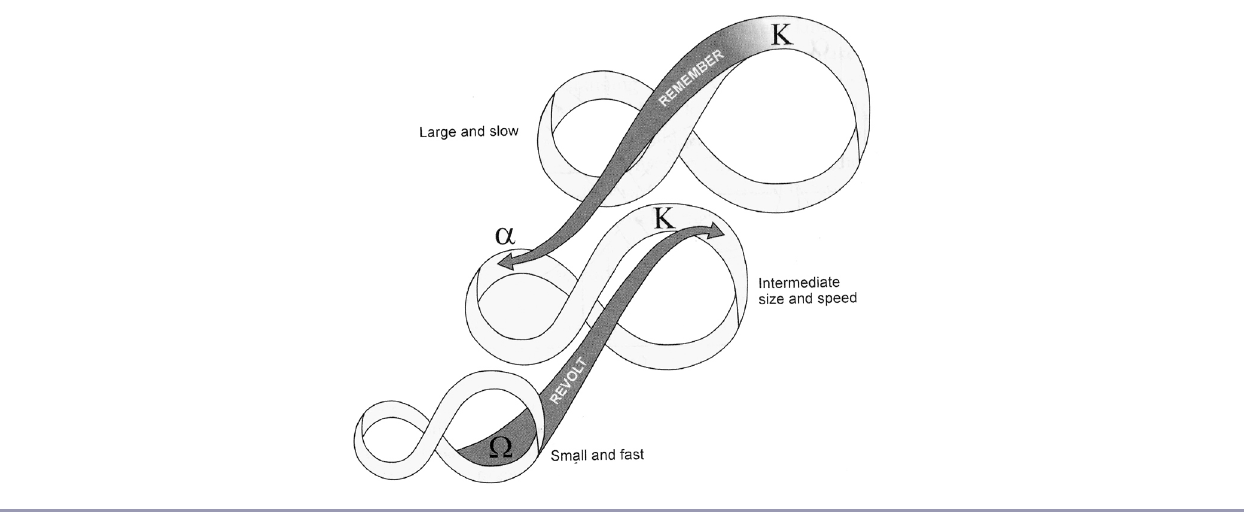
Fig. 2 . Figure 2. A panarchy. Three selected levels of a panarchy are illustrated, to emphasize the two connections that are critical in creating and sustaining adaptive capability. One is the "revolt" connection, which can cause a critical change in one cycle to cascade up to a vulnerable stage in a larger and slower one. The other is the "remember" connection, which facilitates renewal by drawing on the potential that has been accumulated and stored in a larger, slower cycle. The number of levels in a panarchy varies, is usually rather small, and corresponds to levels of scale present in a system. Excerpted from Panarchy: Understanding Transformations in Human and Natural Systems L.